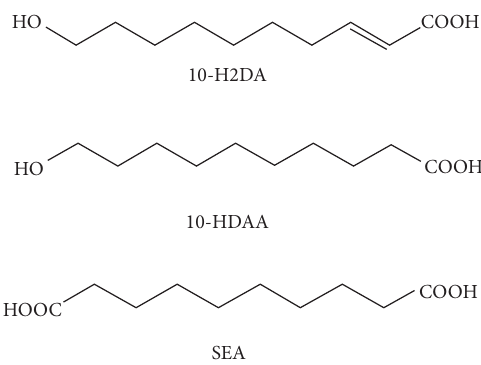
Figure 1: Chemical structures of 10-H2DA, 10-HDAA, and SEA.